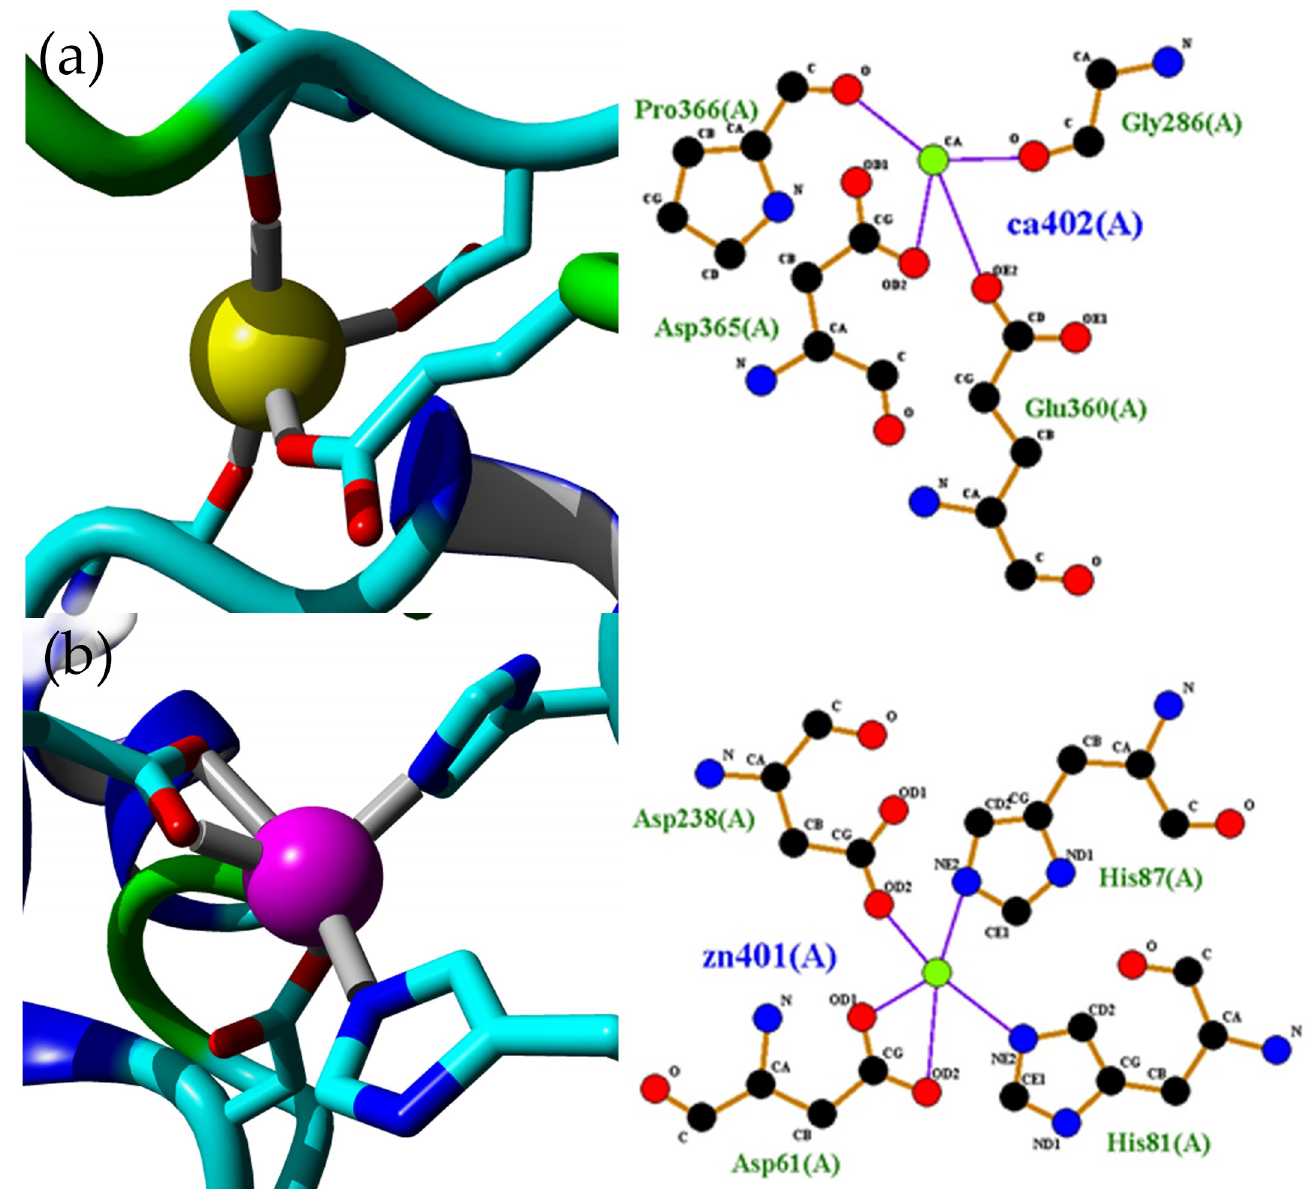
Fig 6. Metal-binding sites in 5M mutant crystal structure. (a) Calcium-binding site in chain A of 5M mutant crystal structure. The calcium-binding site composed of Gly286, Glu360, Asp365, and Pro366. A similar coordination was observed in chain B. (b) Zinc-binding sites in chain A of 5M mutant crystal structure. Zinc-binding site in both chains A and B composed of elements Asp61, Asp238, His87, and His81 in tetrahedral coordination. Hydrogen bonds color in the purple line. Metal ions color in green. The images were generated via YASARA software and LigPlot+ [27,